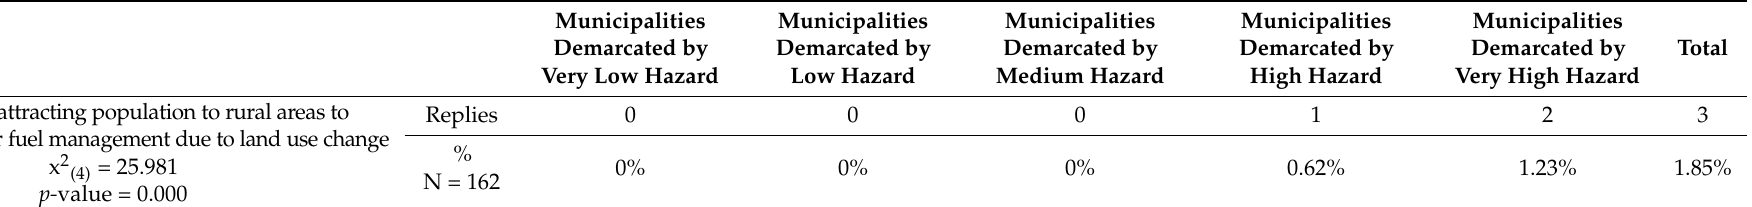
Table 4. Relationships with statistical significance were established between the considered necessity of attracting the population to rural areas to encourage greater fuel management due to land use change and the influence of hazard in municipalities.